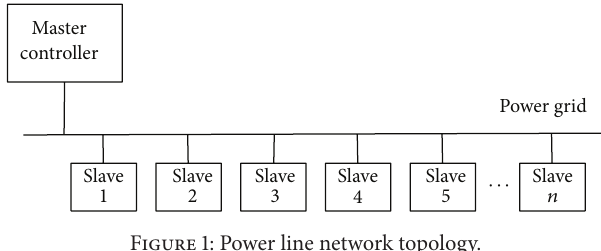
Figure 1: Power line network